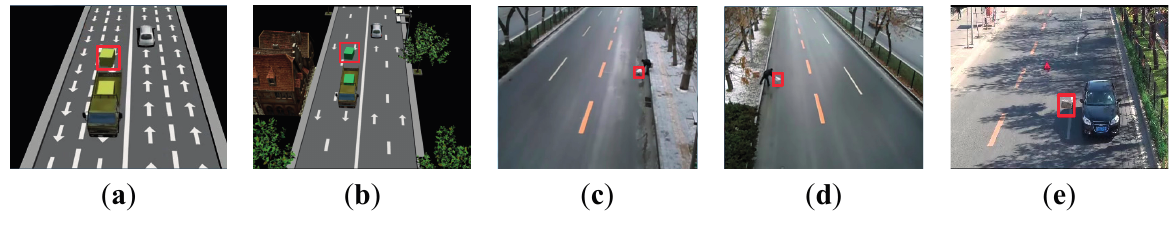
Figure 8. Different situation of simulations and real experiments. ( a , b ) simulation situation; ( c – e ) real road experiment situation.